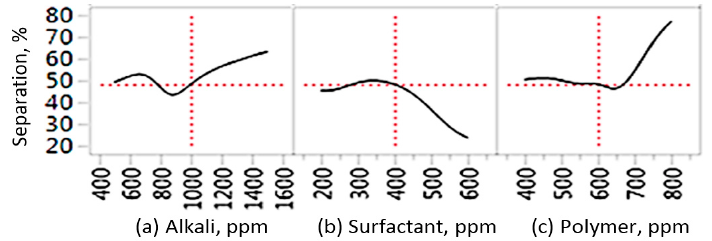
Figure 16. Effect of the process parameters on separation calculated by the developed ANN. ( a ) Alkali separation pro fi le, ( b ) surfactant separation pro fi le, ( c ) polymer pro fi le.